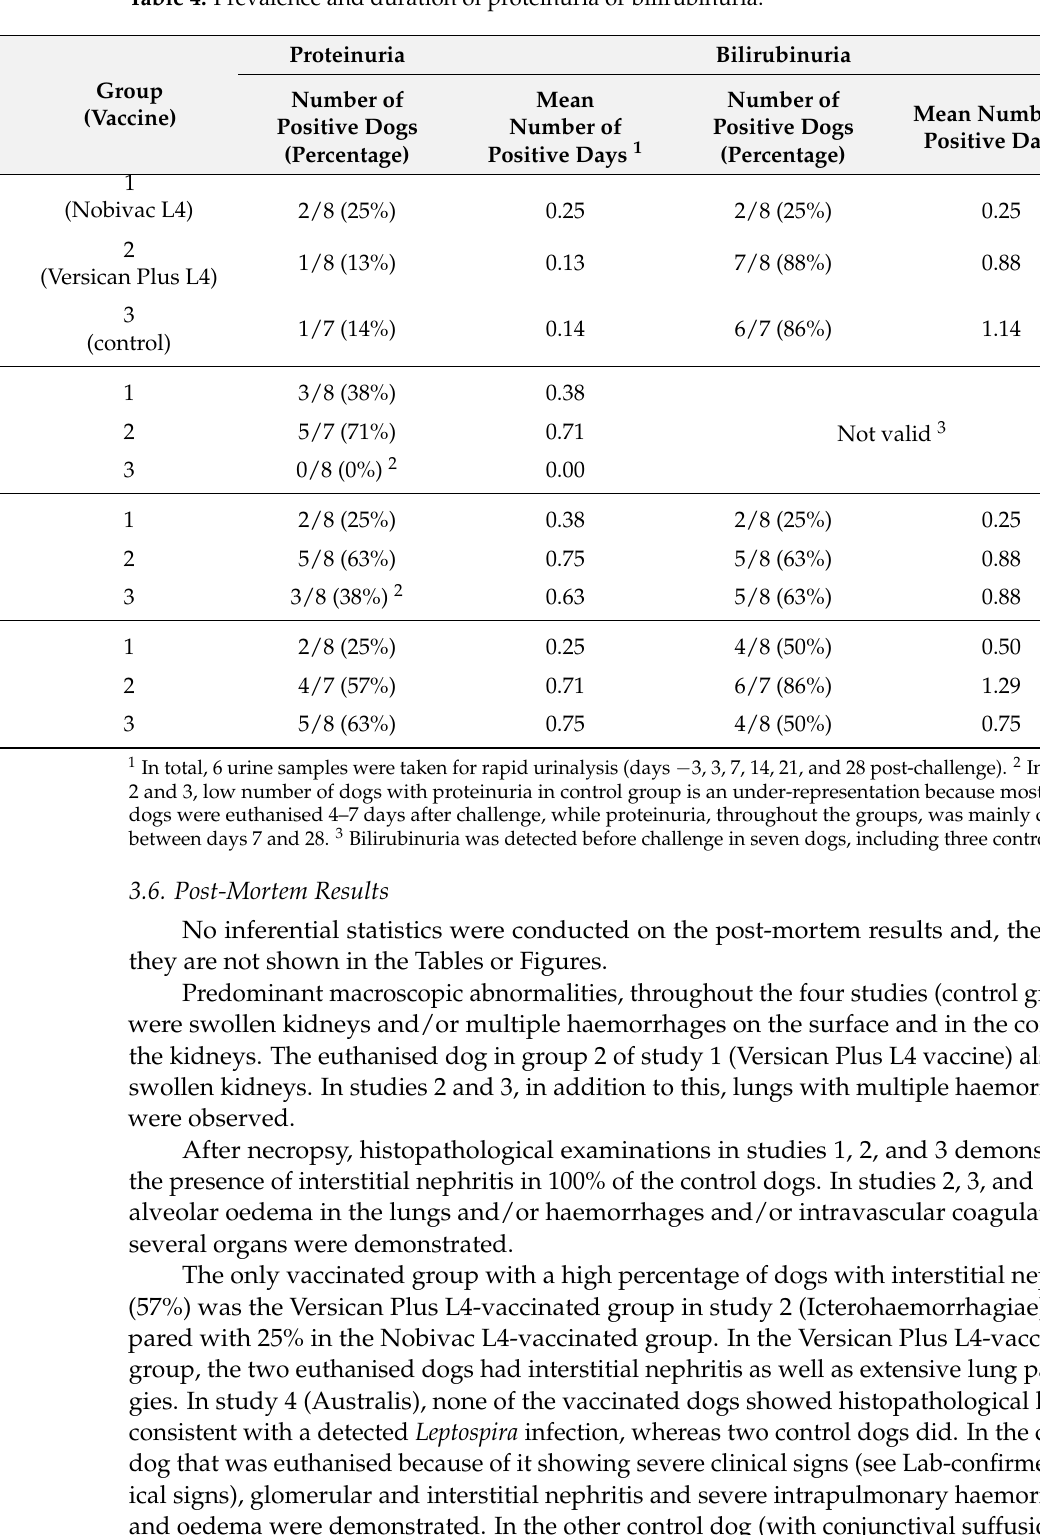
Table 4. Prevalence and duration of proteinuria or bilirubinuria.